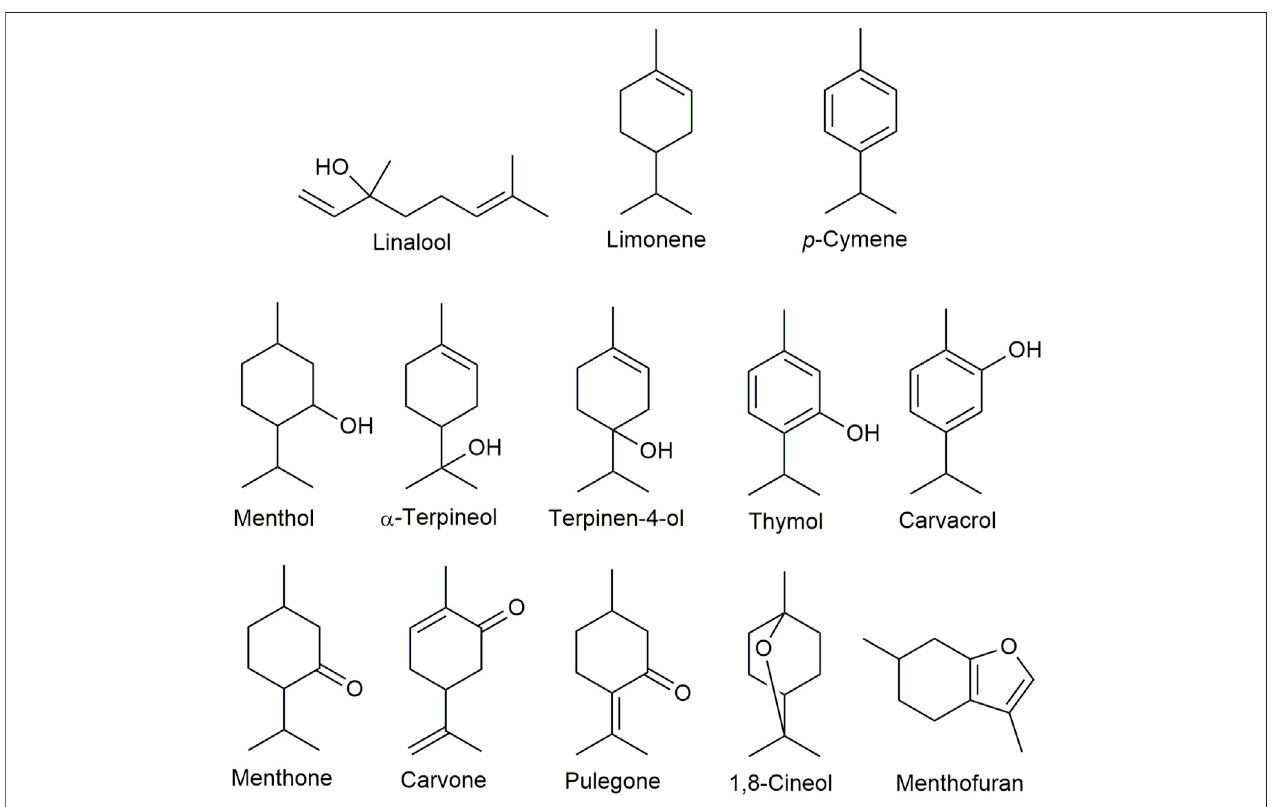
FIGURE 1 | Structures of monoterpenes investigated in this